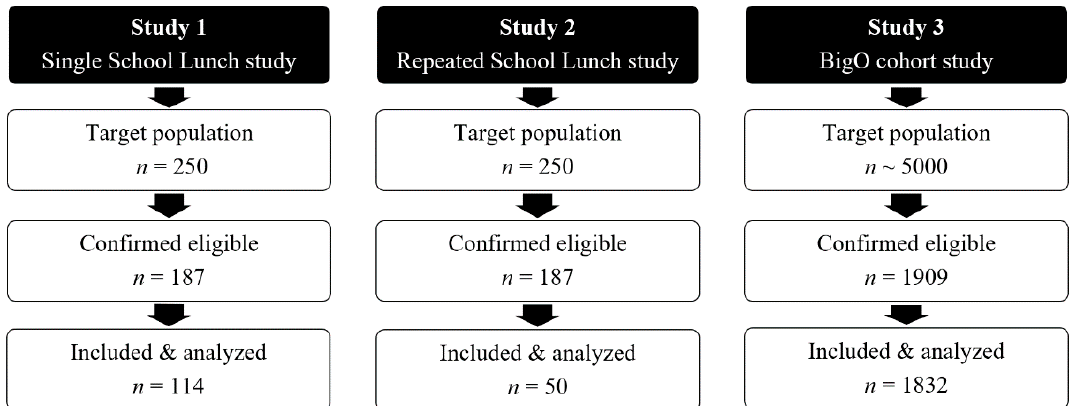
Figure 2. Flow diagram illustrating subjects potentially eligible, confirmed eligible, and included in this study, as well as finally analyzed for studies